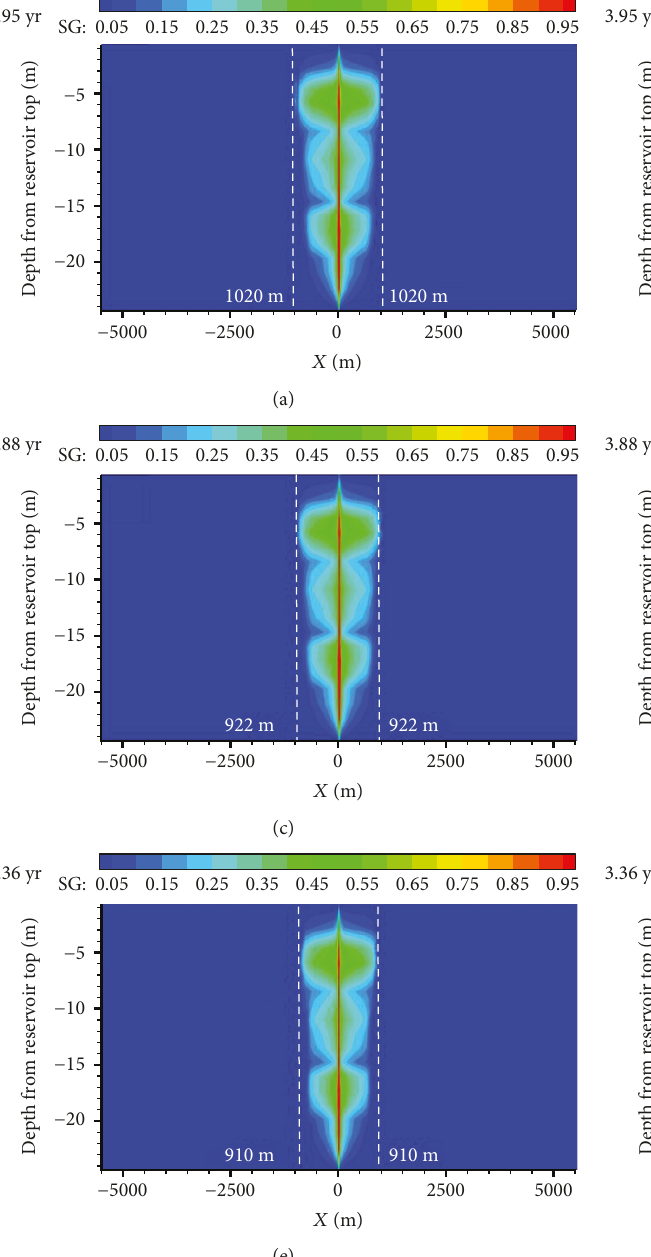
injection at 3.88 years. (d) Two production wells 2